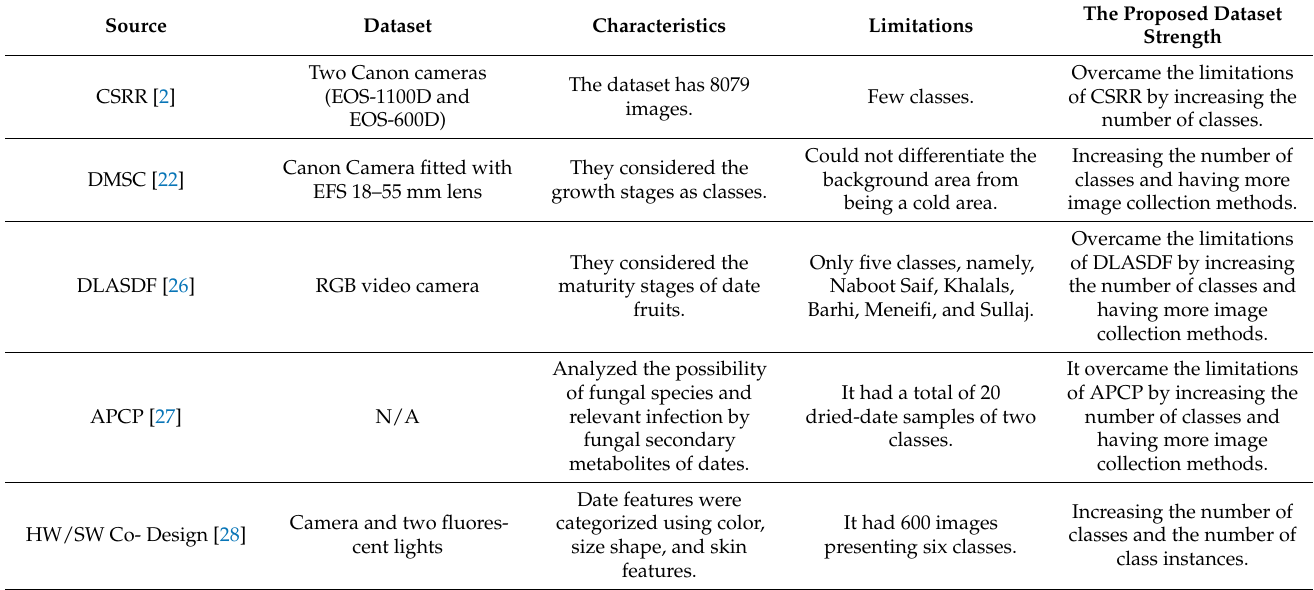
Table 3. Summary of existing date fruit